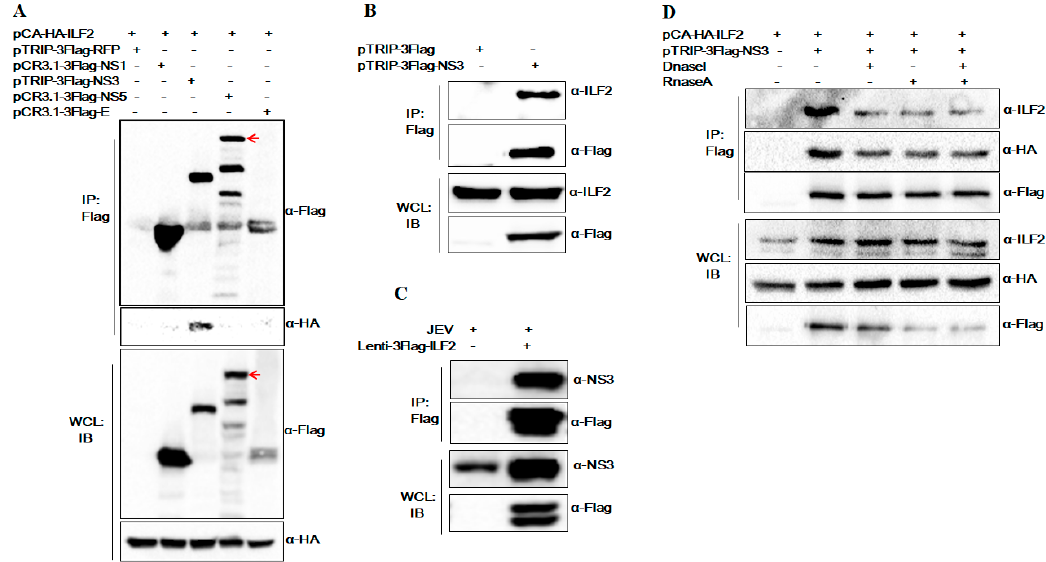
Figure 2. RNA or DNA are not involved in the interaction between ILF2 and JEV NS3. ( A ) The co-transfection of HA-tagged ILF2 with Flag-tagged NS3 / NS5 / NS1 / E was conducted and cell lysates were analyzed by immunoprecipitation analysis with anti-Flag beads 24 h post-transfection. Western blot assay was then detected with the indicated antibodies. ( B ) The interaction between endogenous ILF2 and JEV NS3 was confirmed by co-precipitation. 293T cells were transfected with pTRIP-3Flag-NS3 or pTRIP-3Flag. Cell extracts were subjected to immunoprecipitation (IP) using anti-Flag beads and detected with anti-ILF2 or anti-Flag antibodies. ( C ) The interaction of ILF2 with NS3 was examined in JEV-infected 293T cells. 293T cells were transduced with lentiviruses expressing 3Flag-ILF2 for 48 h. Cells were infected with JEV at an MOI of 1.0 and cell lysates were harvested at 24 h post-infection for co-immunoprecipitation with anti-Flag beads, and were then detected with anti-NS3 polyclonal antibodies or anti-Flag antibodies. ( D ) 293T cells were co-transfected with pCA-HA-ILF2 and pTRIP-3Flag-NS3 plasmid for 24 h. Then, cell lysates treated with or without RNase A and Dnase I were harvested for co-immunoprecipitation with anti-Flag beads, and then detected with anti-HA and anti-Flag antibodies.